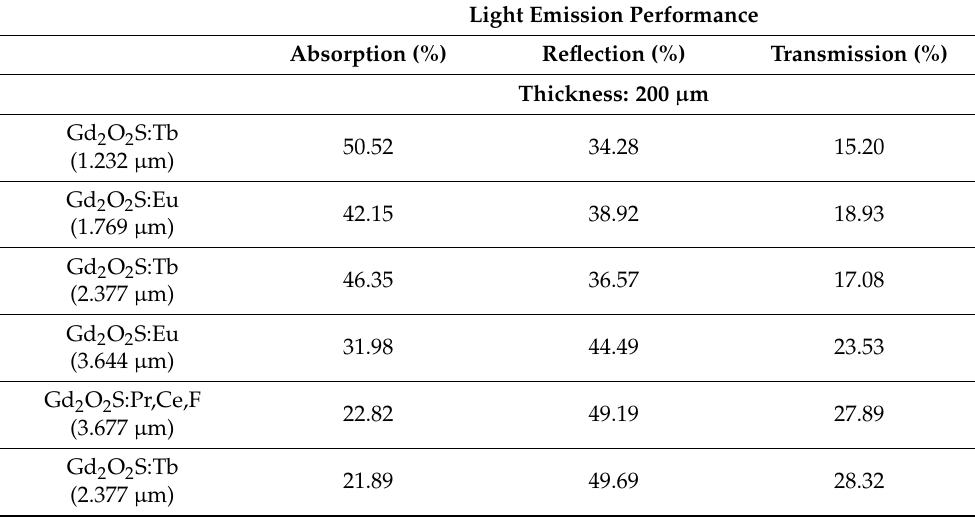
Table 4. Light emission performance (absorption, transmission, and reflection) of different